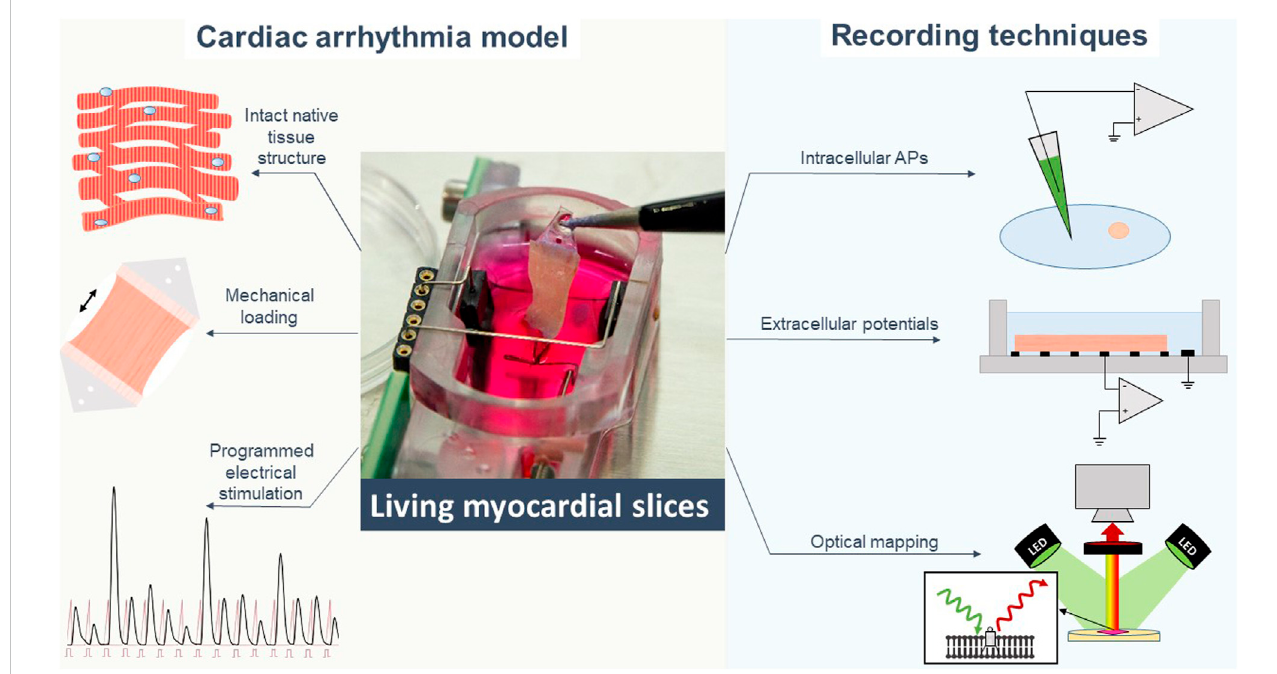
FIGURE 2 Livingmyocardialslicesareacardiacarrhythmiamodelwithhighdegreeof in-vivo mimicrytowhichdifferentelectrophysiologicalrecordingtechniques can be applied. APs action